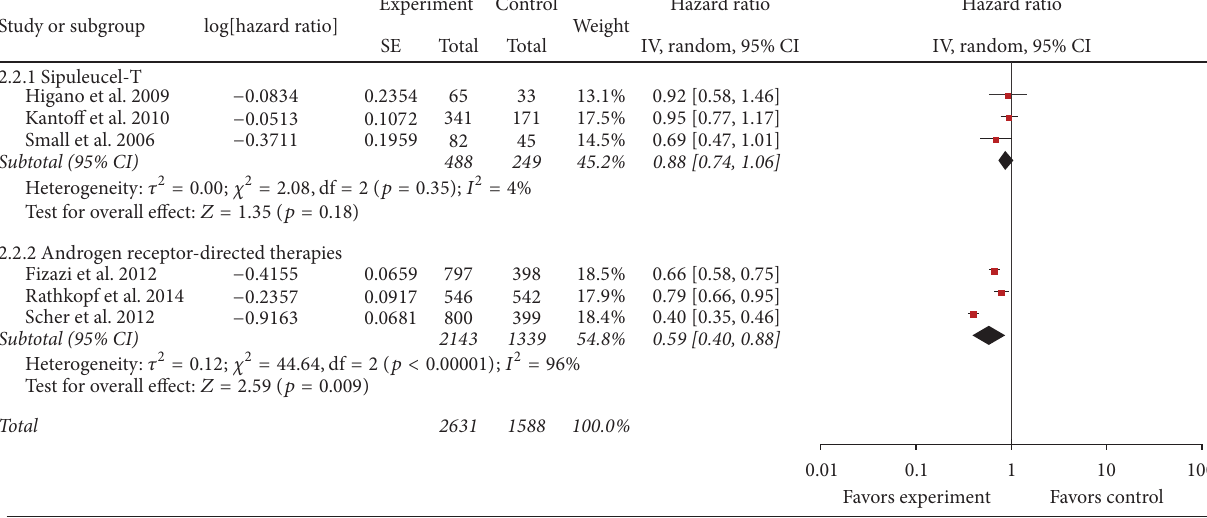
Figure 3: Forest plot of hazard ratio of time-to-progression of sipuleucel-T and androgen receptor-directed therapies compared with placebo in men with castration-resistant prostate cancer. The bars with squares in the middle represent 95% confidence intervals (95% CIs) and HRs. The central vertical solid line indicates the HRs for null hypothesis. The size of the diamonds represents the weight for the random-effect model in the meta-analysis.